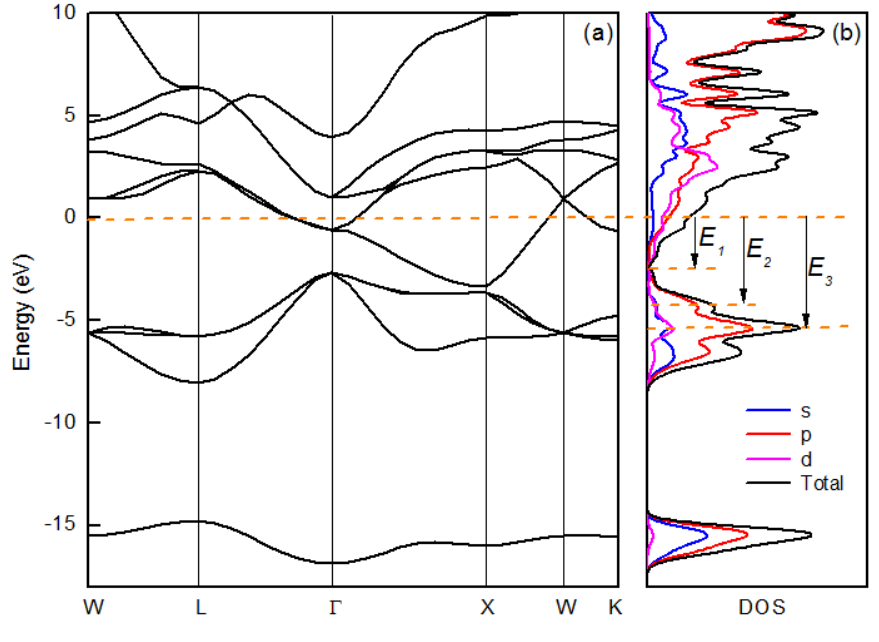
Figure 5. Electronic band structure ( a ) and the density of states (DOS) ( b ) of Ti 0.5 Zr 0.5